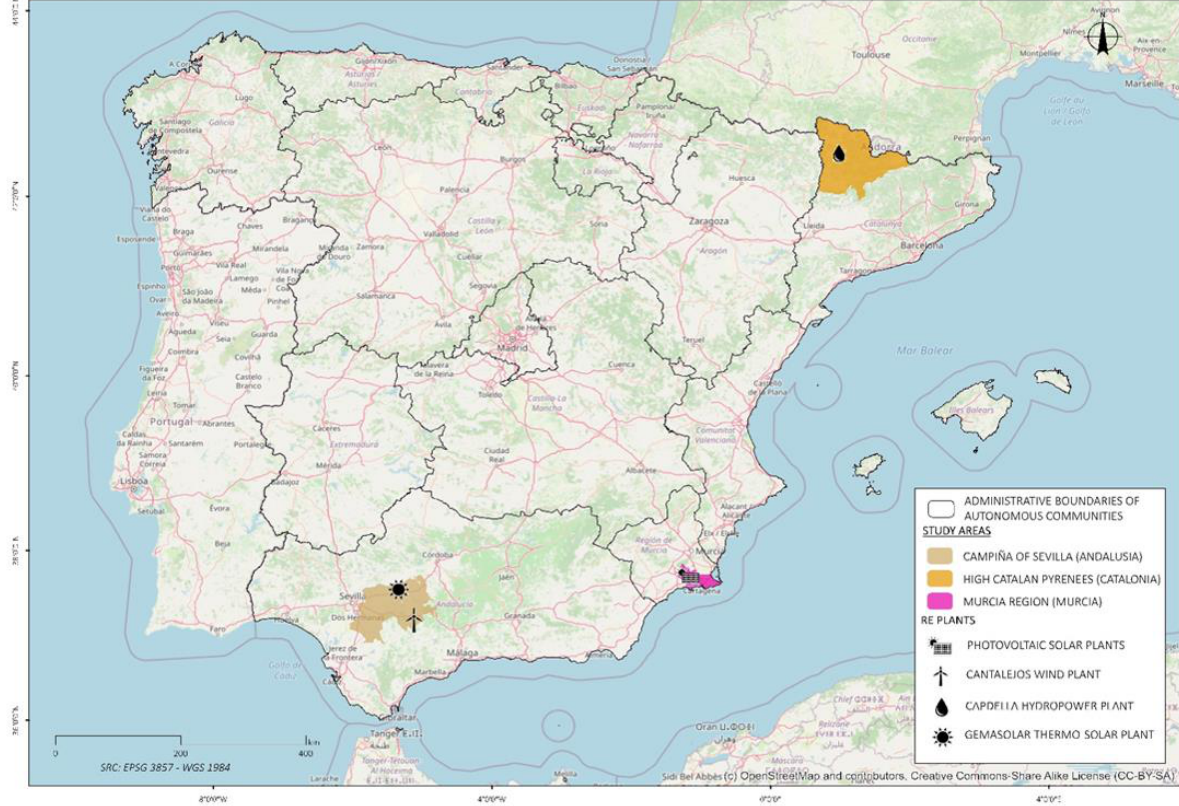
Figure 1. Study areas and renewable energy plants (REPs).